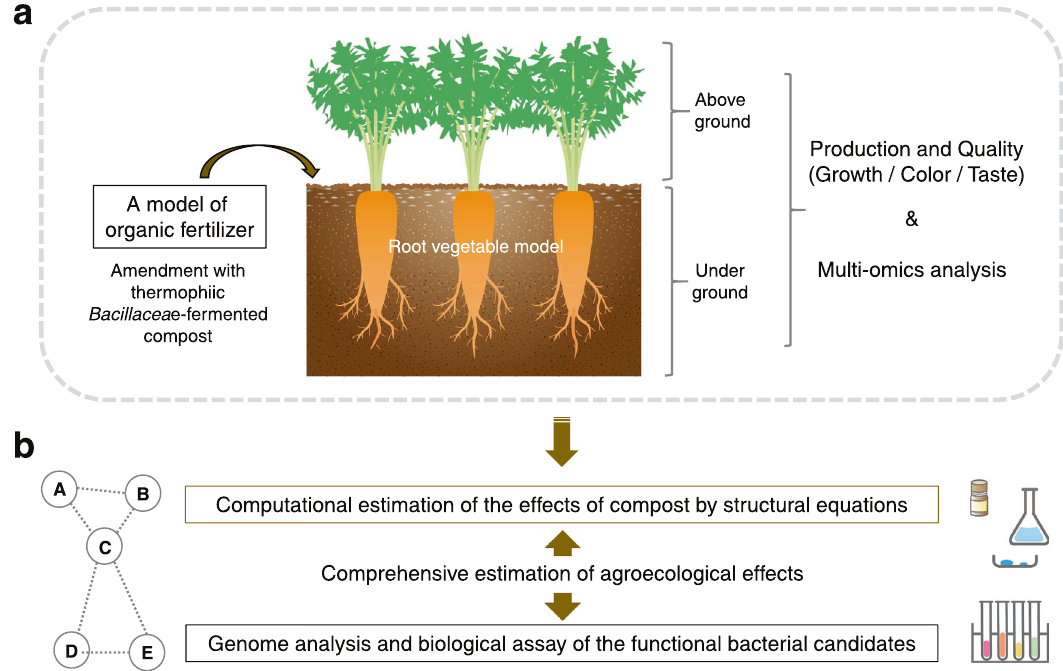
Fig. 1 The conceptual procedures of this study. a Compost fermented with thermophilic Bacillaceae was used as a model for organic fertilizer and applied to carrots as a model for root vegetables. After the amendment, factors related to the productivity and quality of the carrots were analyzed, along with multi-omics analysis in aboveground and underground portions. b Based on these data, the computational structure of physiological effects by compost using structural equations was inferred. The bacterial candidates that could be involved in compost functionality based on the information were isolated. Genome analysis and biological assays on them were performed. The combination provided a comprehensive estimation of the molecular mechanisms of compost (see Fig. S1 in Supplementary information for a supplementary explanation of this